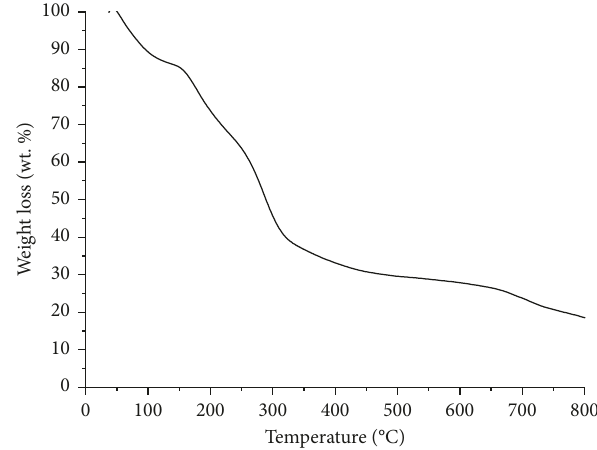
Figure 1: TGA curves of Cu- β -CD catalyst.